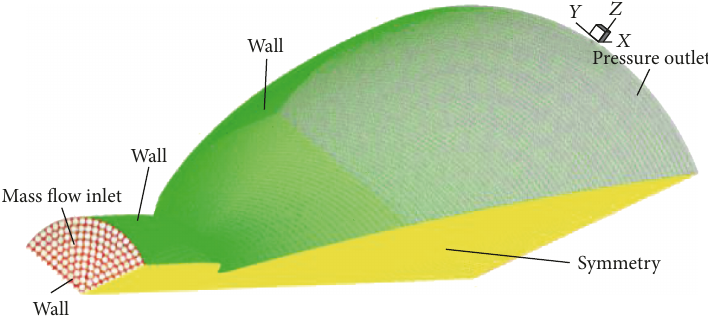
Figure 1: Mesh and boundaries of engine internal fl ow fi eld.